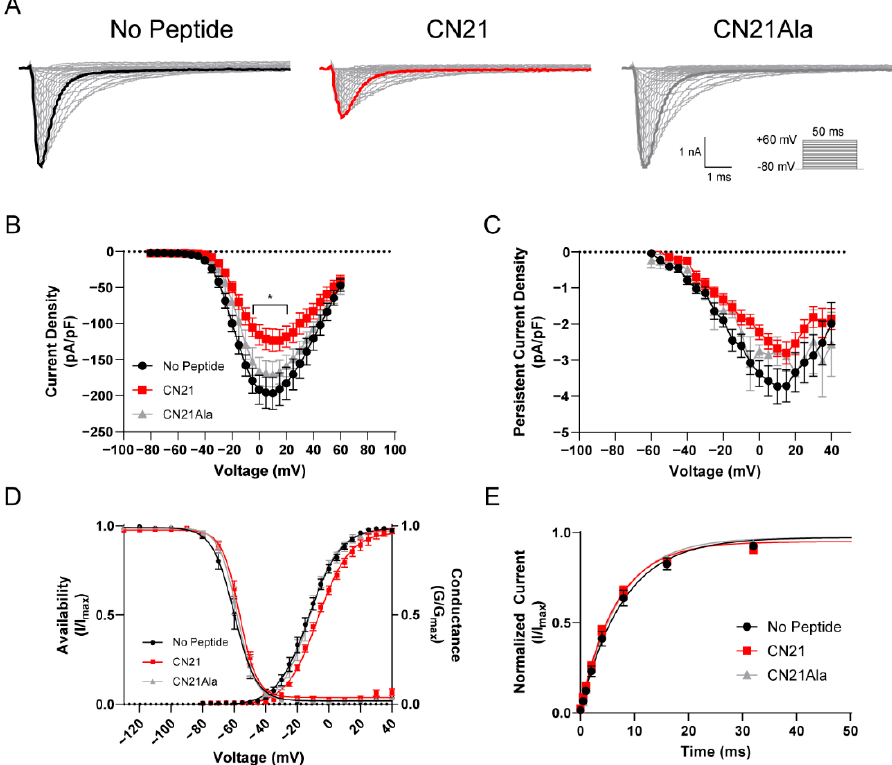
Figure 2. CaMKII inhibition of the R850Q mutant channel reduces the current density and shifts the activation midpoint to more depolarizing potentials. ( A ) Representative family of current traces generated by Nav1.6 mutant R850Q with no peptide (black, left), CN21 (red, middle), or CN21Ala (gray, right) in the patch pipette elicited with a voltage–step protocol (inset). Peak current traces are in boldface. ( B ) Transient current density–voltage and ( C ) persistent current density–voltage curves. ( D ) Voltage dependence of activation and availability curves for R850Q treated with or without CN21 or CN21Ala each fitted with a Boltzmann function. ( E ) Rate of recovery from fast inactivation. CaMKII inhibition reduces R850Q current density and shifts the voltage dependence of activation to more positive potentials. * p < 0.05; n = 5–12 per group; two-way ANOVA ± SEM (error bars), Tukey’s post hoc test.